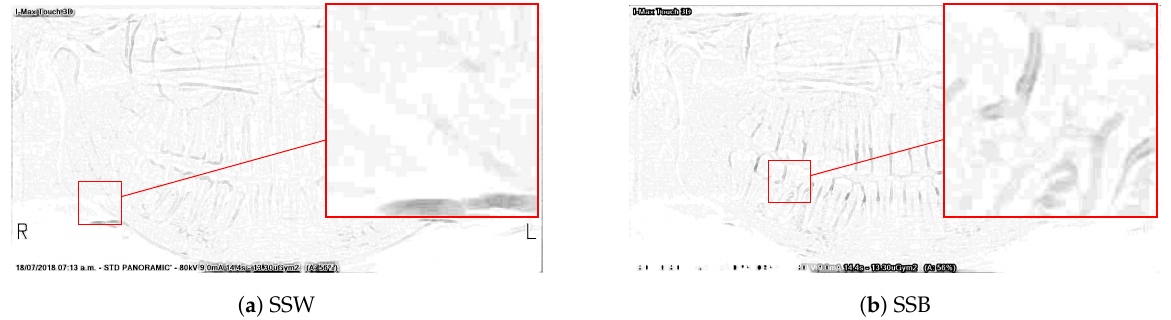
Figure 3. Differences in the bright and dark areas